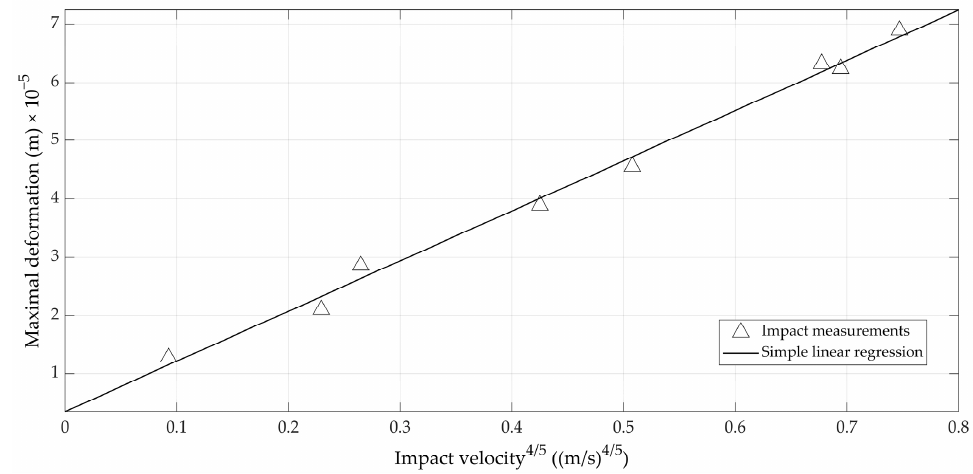
Figure 5. Relation between the impact velocity and the maximal deformation of the eggshell.